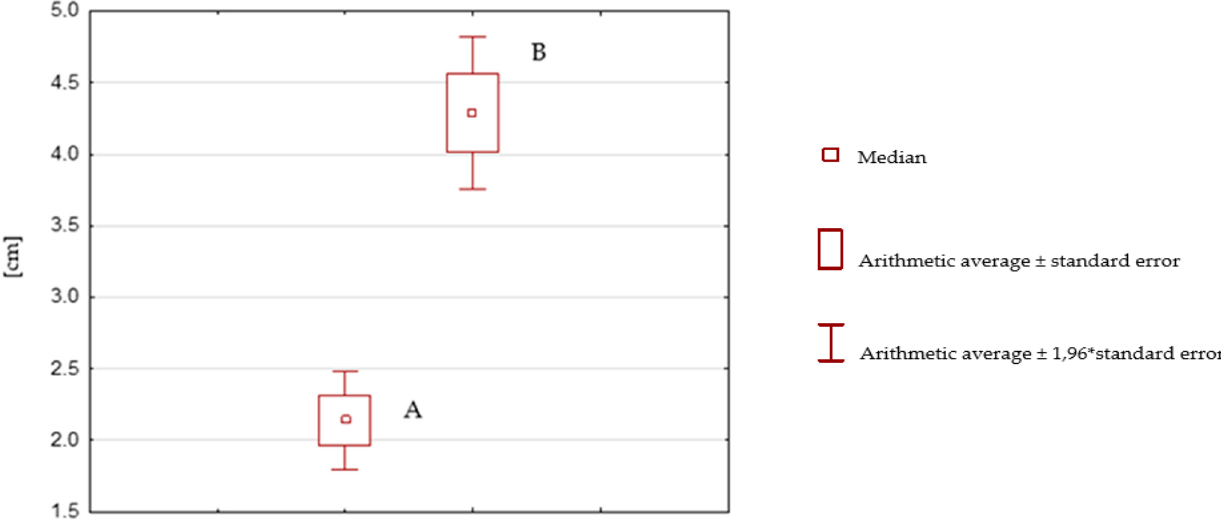
Figure 7. Box plot after rehabilitation with SPIDER system ( A ) versus before rehabilitation with SPIDER system ( B ).